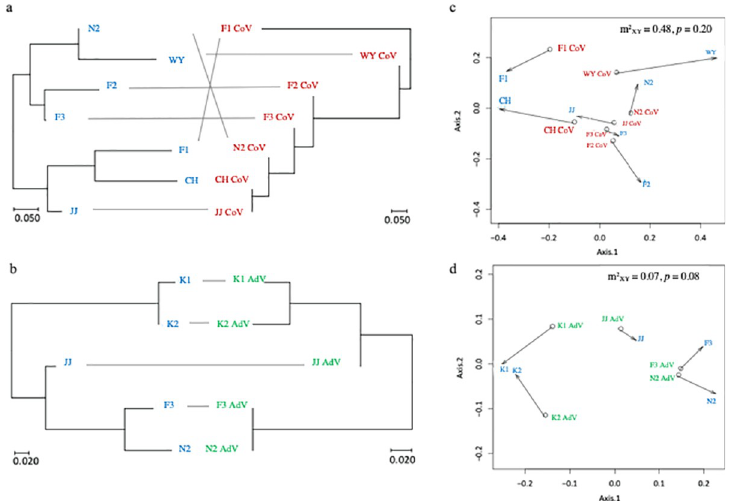
Fig 4. Congruence of phylogenetic patterns between M . fuliginosus and the related viruses. Comparison of population phylogenetic trees of A) M . fuliginosus and bat alphaCoV, and B) M . fuliginosus and BtAdV. Procrustean superimposition plots of C) M . fuliginosus and bat alphaCoV, and D) M . fuliginosus and BtAdV produced using PACo. D-loop of M . fuliginosus in each population are represented in blue color. Bat alphaCoV and BtAdV populations are represented in red color and green color,